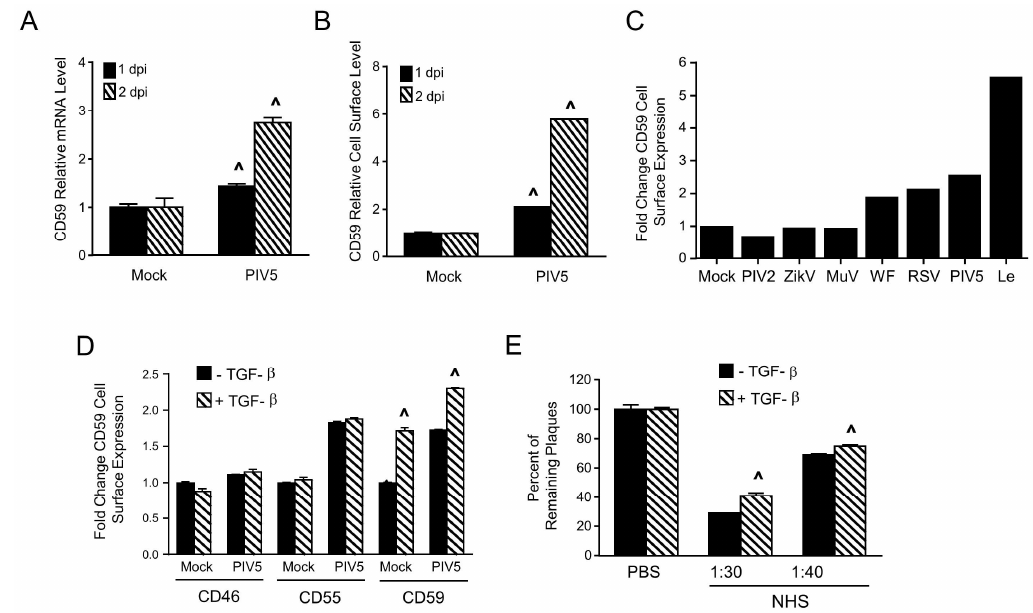
Figure 8. CD59 cell surface expression is upregulated following PIV5 infection, which results in viruses with higher resistance to complement-mediated neutralization. ( A , B ) A549 cells were mock infected or infected with PIV5 at an moi of 10. At 1 and 2 dpi, total RNA was isolated for qRT-PCR quantitation of relative levels of CD59 mRNA (panel ( A )) or cells were analyzed for surface-expression of CD59 by flow cytometry (panel ( B )). The data are from three independent reactions and error bars represent standard deviation. ^ p < 0.01 when comparing PIV5-infected cells to mock infected cells. ( C ) A549 cells were mock infected or infected with the indicated viruses at an moi of 10 and levels of cell surface CD59 were quantitated by flow cytometry at 2 dpi. Results are an example of two independent experiments. ( D ) A549 cells were mock infected or infected with PIV5 at an moi of 10. At 16 hpi, cells were treated with 5 ng/mL of TGF- β 1. At 2 dpi, levels of cell surface CD46, CD55, and CD59 were quantitated by flow cytometry. The data are from three independent reactions and error bars represent standard deviation. ^ p < 0.01 when comparing TGF-treated cells to mock treated cells. ( E ) PIV5 was grown in untreated A549 cells or TGF- β 1-treated cells. One hundred PFU of the resulting virus was incubated with PBS as a control or with the indicated dilutions of NHS for 1 h. Remaining infectivity was determined by using a plaque assay. The data are from three independent reactions and error bars represent standard deviation. ^ p < 0.01 when comparing PIV5 derived from TGF- β 1 treated cells to PIV5 derived from control